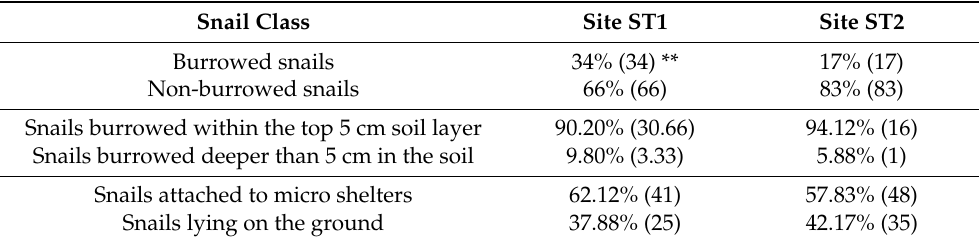
Table 2. Distribution of snails across different classes related to the burrowing behavior.